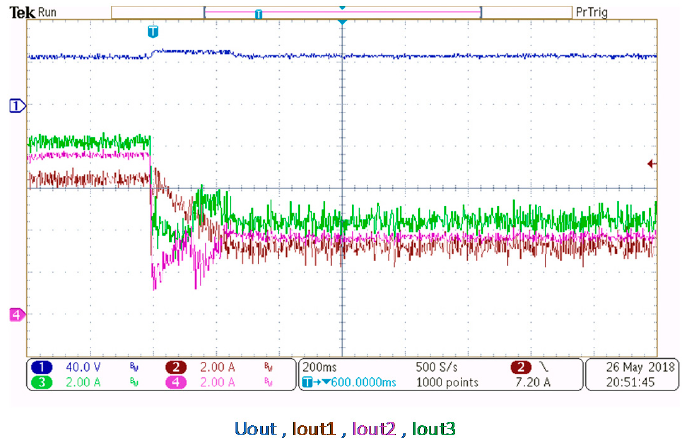
Energies 2018 , 11 , x FOR PEER REVIEW Figure 10. Dynamic load change from 100% to 20% of P OUT for frequency follower control strategy.